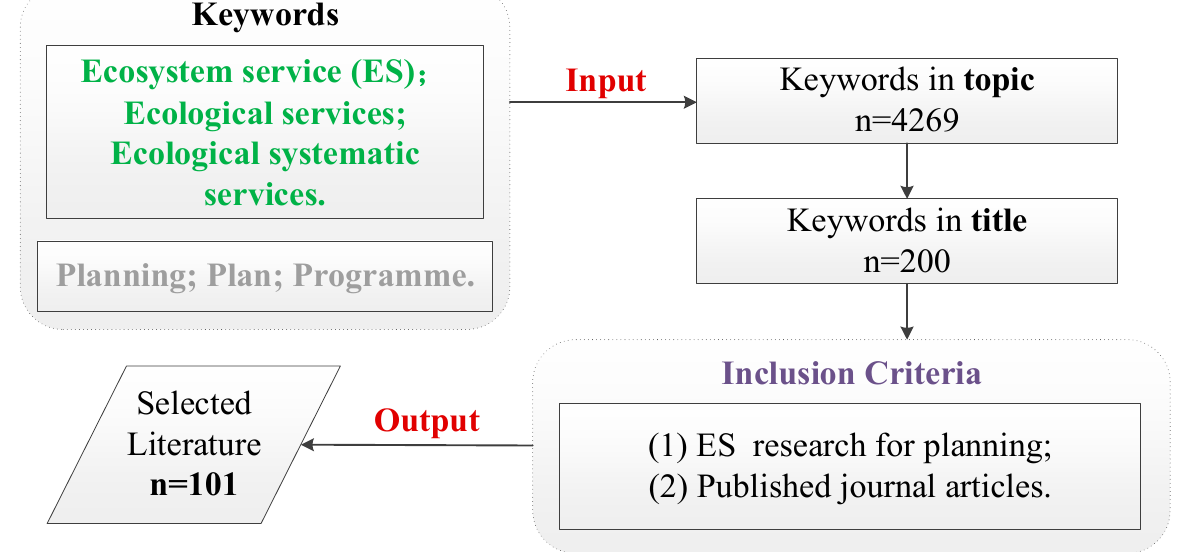
Figure 1. Simplified literature search utilizing the Web of Science and samples selection flow process for the review. Inclusion criteria focus on the published journal articles and ES research that serves to guide the planning practice.